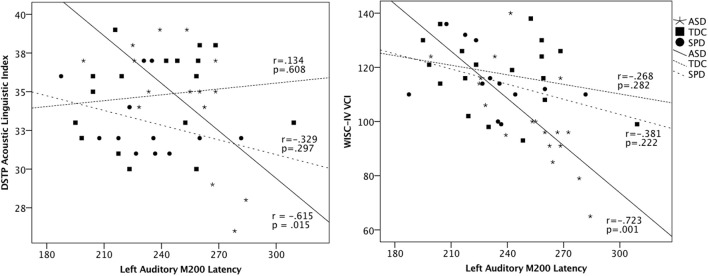
Scatterplots of DSTP Acoustic Linguistic Index, WISC-IV Verbal Comprehension Index, and the left auditory M200 latencies in each group. These associations were statistically significant in the ASD group, who showed a significant delay in the M200 response; however, the inclusion of all groups in the scatterplot highlights the intermediate profile of the SPD group relative to the ASD and TDC participants.